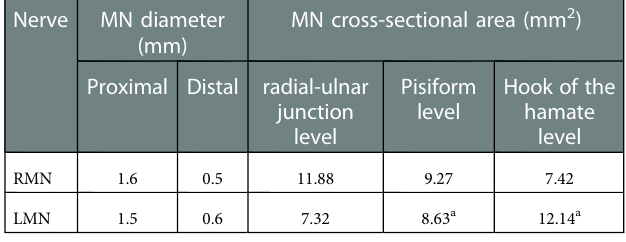
( Supplementary Figure S2 ). The strength of the bilateral muscle abductor pollicis brevis muscle and opponens pollicis muscle were 5 − /5 (MRC).